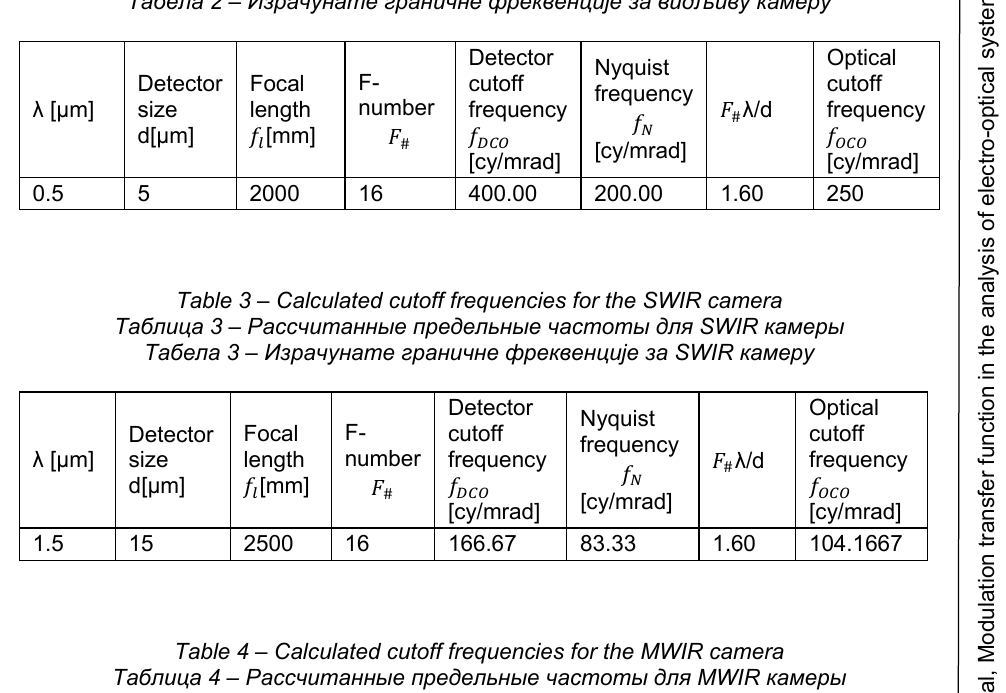
Table 2 – Calculated cutoff frequencies for the visible camera